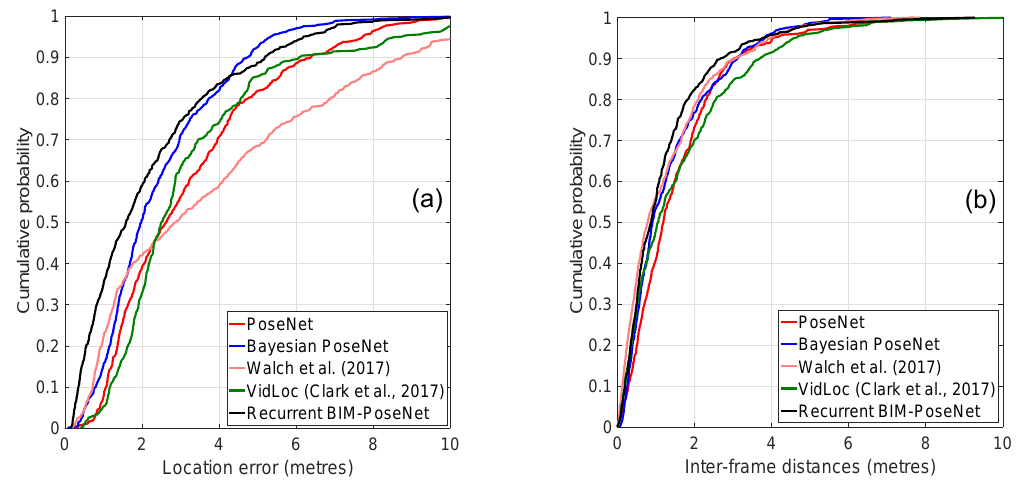
Figure 10. CFD plots of the ( a ) localisation errors and ( b ) inter-frame distances of the estimated camera poses for different approaches for Gradmag-Syn-car